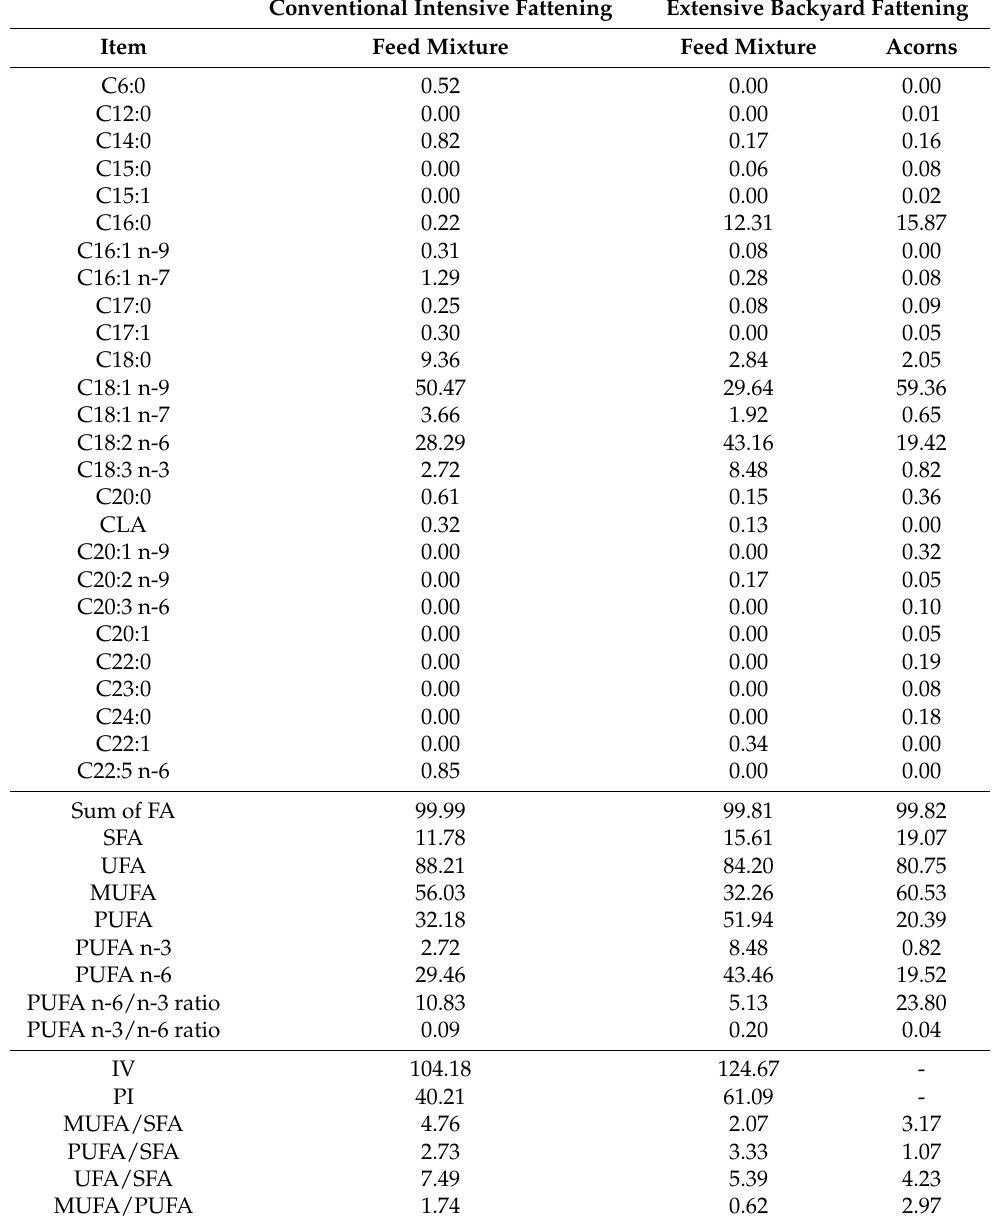
Table 1. Fatty acid profile (g/100 g of all estimated acids) and lipid quality indices of the feed mixtures and acorns used in different fattening types. Conventional Intensive